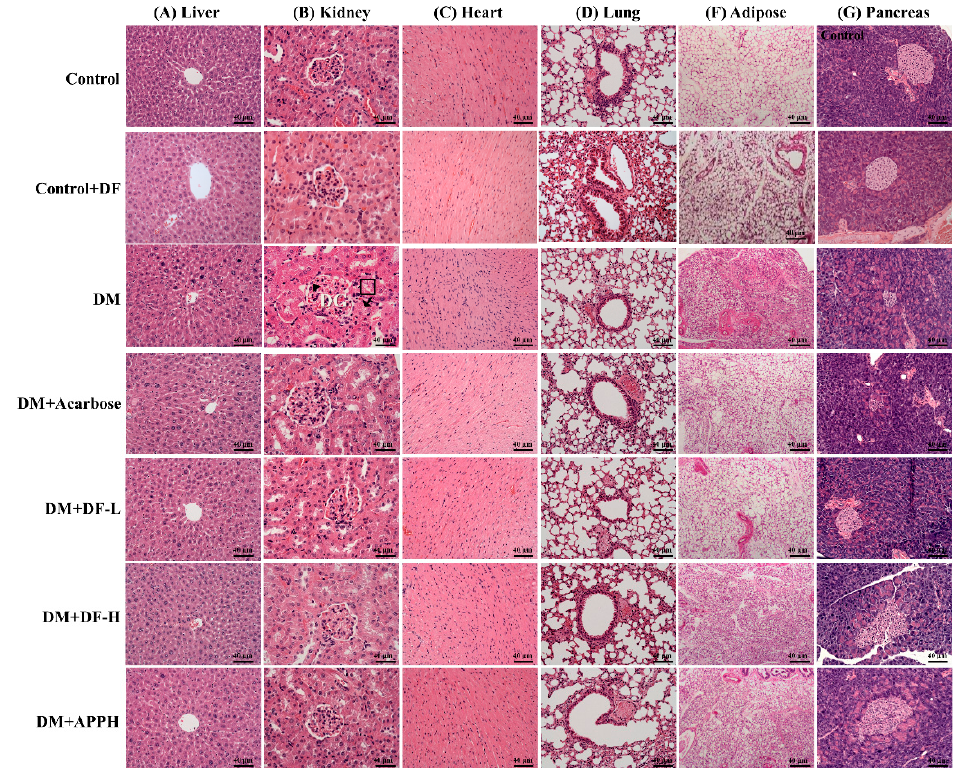
Figure 4. DF-induced changes in the histopathology of DM animals. Hematoxylin and eosin (H and E) stainings of tissue sections from liver, kidney, heart, lung, adipose tissue, and pancreas show differences in the histopathology in control mice (Control), non-diabetic mice treated with DF (Control+DF), STZ-induced diabetes mellitus mice (DM), DM mice treated with acarbose (DM+Acarbose), DM mice treated with low-dose DF peptide (DM+DF-L), DM mice treated with high-dose DF peptide (DM+DF-H), and DM mice treated with APPH peptide (DM+APPH).